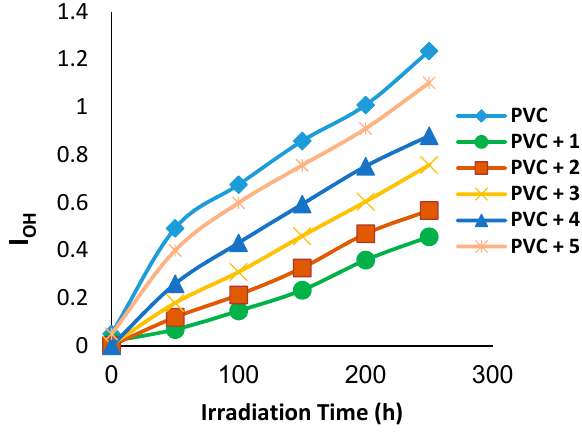
Figure 5. The relationship between the irradiation time (h) and hydroxyl index ( I OH ) for PVC films (30 μ m thickness) with Schiff’s bases 1 – 5 (0.5% by weight) as additives.